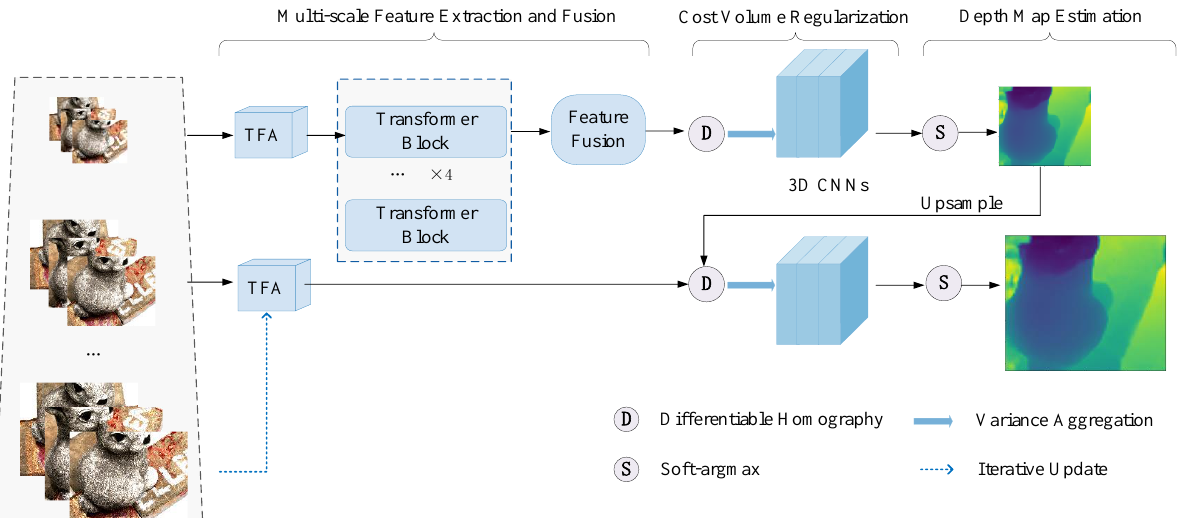
Figure 1. The network structure of MVS-T.